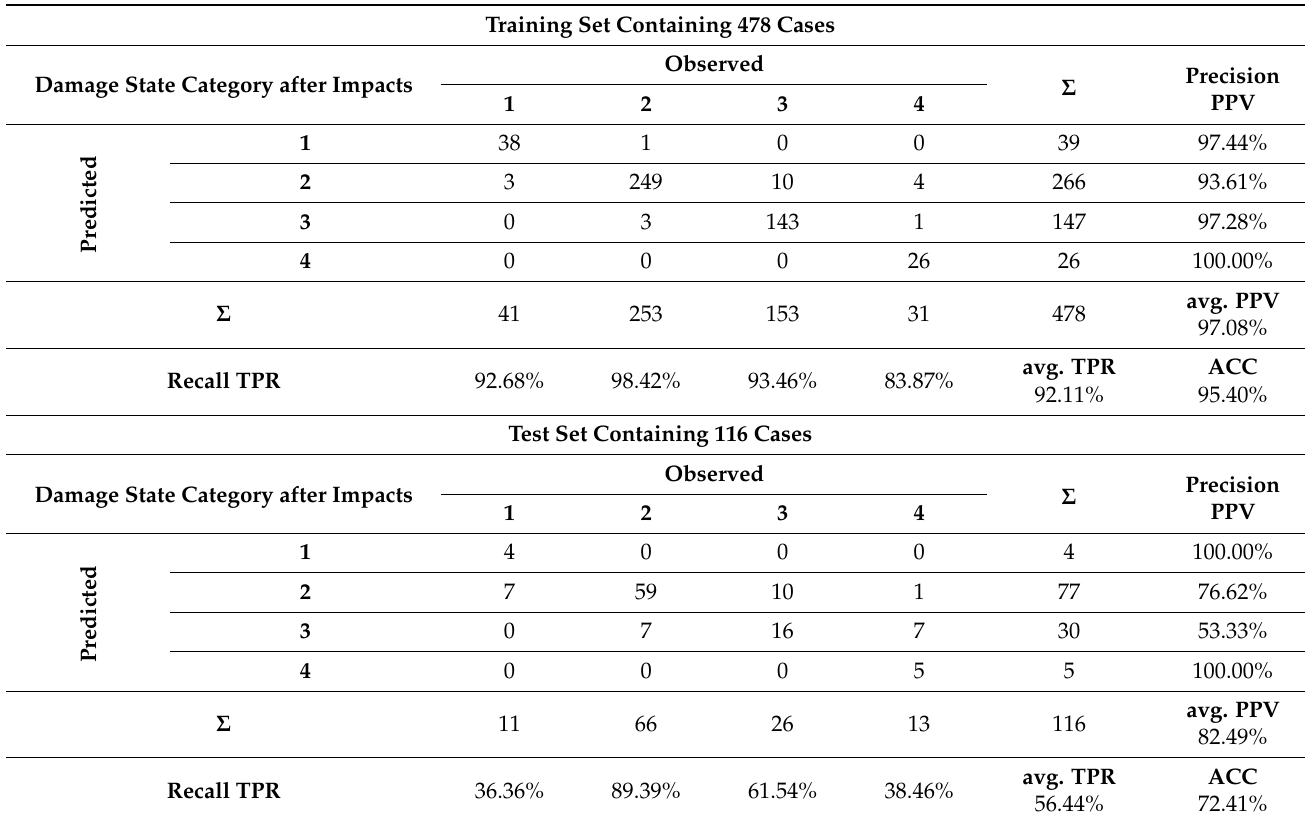
Table 4. Confusion matrix for the SVM classifier—accuracy of classification, average precision and average recall for training and test